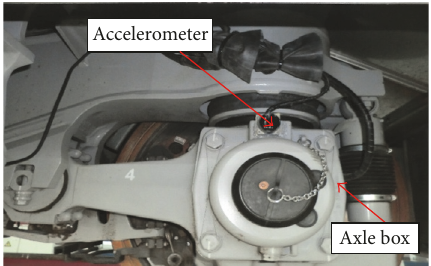
Figure 18: Measurement sensor installed on axle box in a high-speed